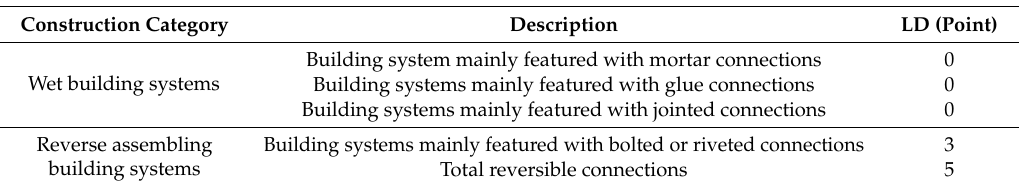
Table 1. Level of Disassembling (LD) score for the building systems analyzed.